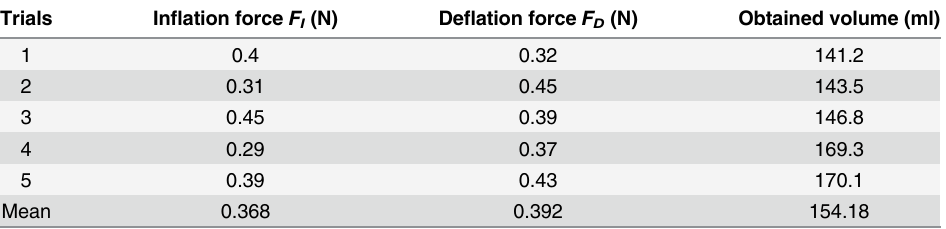
Table 3. Force and balloon volume measurement for the proposed